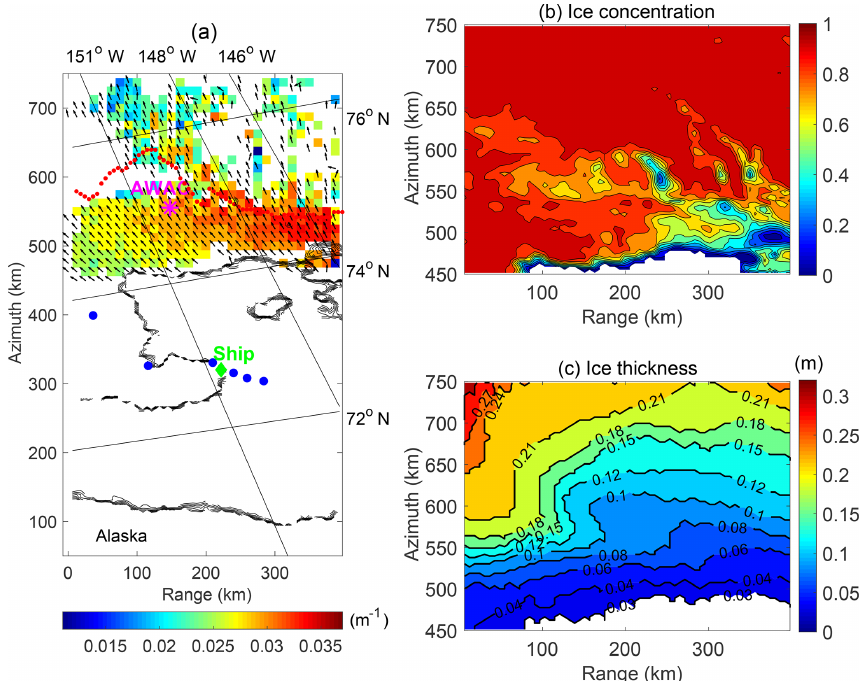
Figure 1. (a) Overview of the retrieved data distribution around 16:50UTC on 12 October 2015. Colors represent the dominant wave number, and arrows represent the main direction of the dominant wave number. Red dots indicate the first appearance of leads (FAL). Locations of the Sikuliaq ship and the buoys operating at that time are indicated by a green diamond and blue dots, respectively. AWAC-I is marked by a magenta asterisk. Ice edges are indicated by contours of ice concentration < 0 . 4 from AMSR2. (b, c) Distributions of ice concentration (AMSR2) and ice thickness (SMOS) in the selected region,